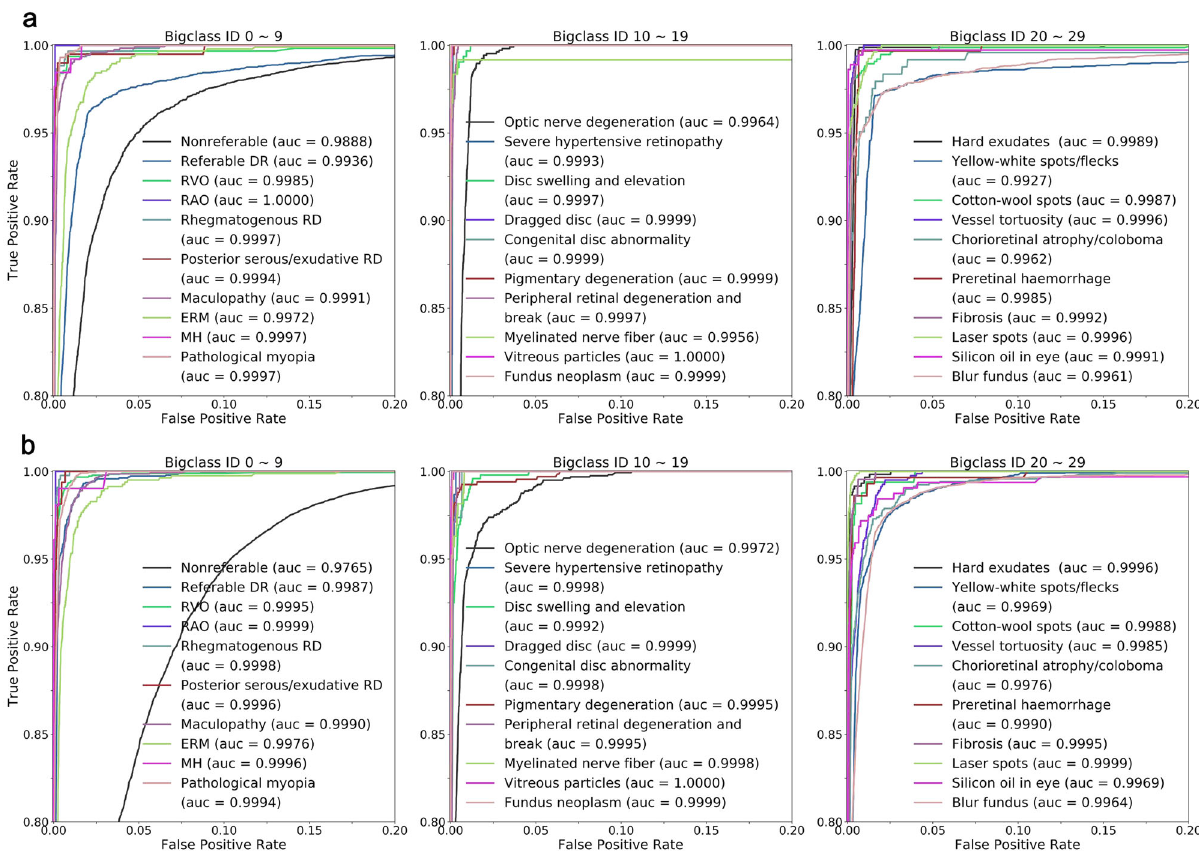
Fig. 2 ROC and AUC of DLP for detection of bigclasses in primary test and multihospital test data sets. a ROC curves and AUC for detecting every bigclass in primary test were calculated and plotted. Different colors of ROC curves corresponding to different AUC of each disease and condition are listed. b ROC curves and AUC for detecting every bigclasses in multihospital test. Source data are provided as a Source Data fi